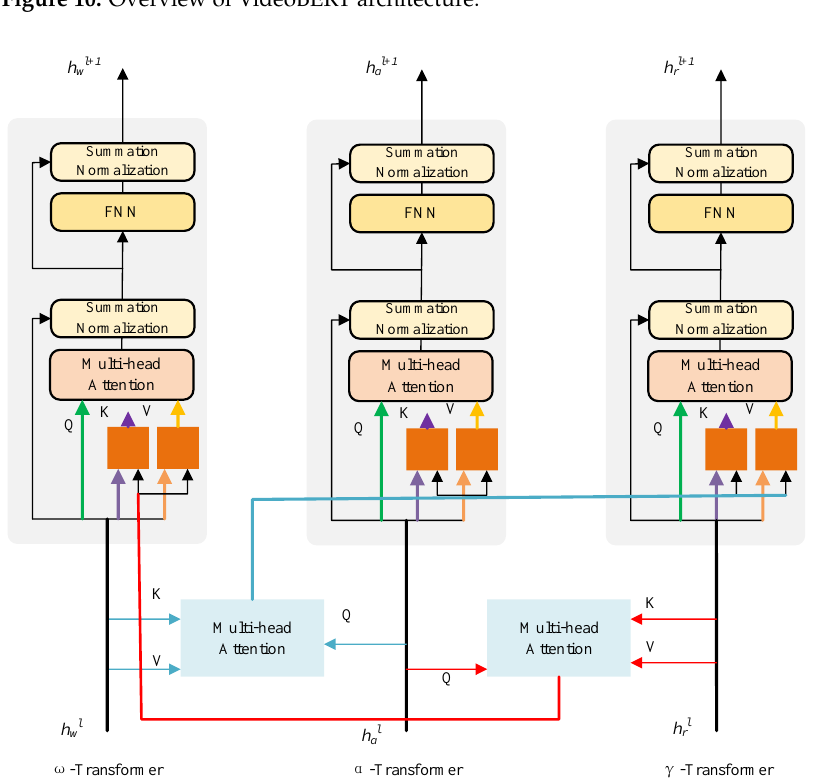
Figure 10. Overview of VideoBERT architecture.